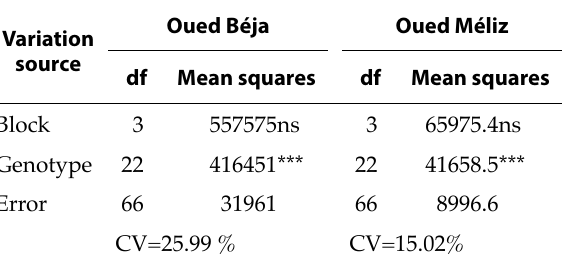
Table 2. Analysis of variance of ascochyta blight severity (measured as Area Under the Disease Progress Curve) of 23 chickpea genotypes grown at two different locations and under controlled